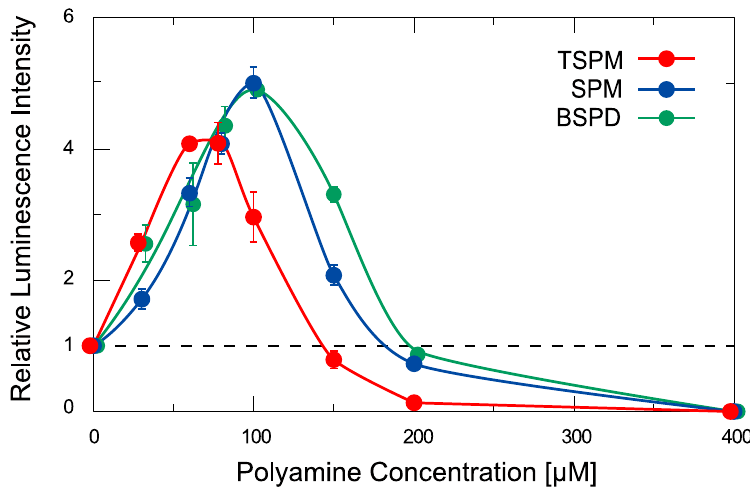
Figure 3. Efficiency of gene expression vs. concentrations of the polyamines TSPM, SPM, and BSPD, as observed from the emission intensity of luciferin–luciferase reaction. The intensity is normalized to the control condition (=1). The DNA concentration was set at 0.3 μ M in nucleotide units. The error bar shows the standard deviation.